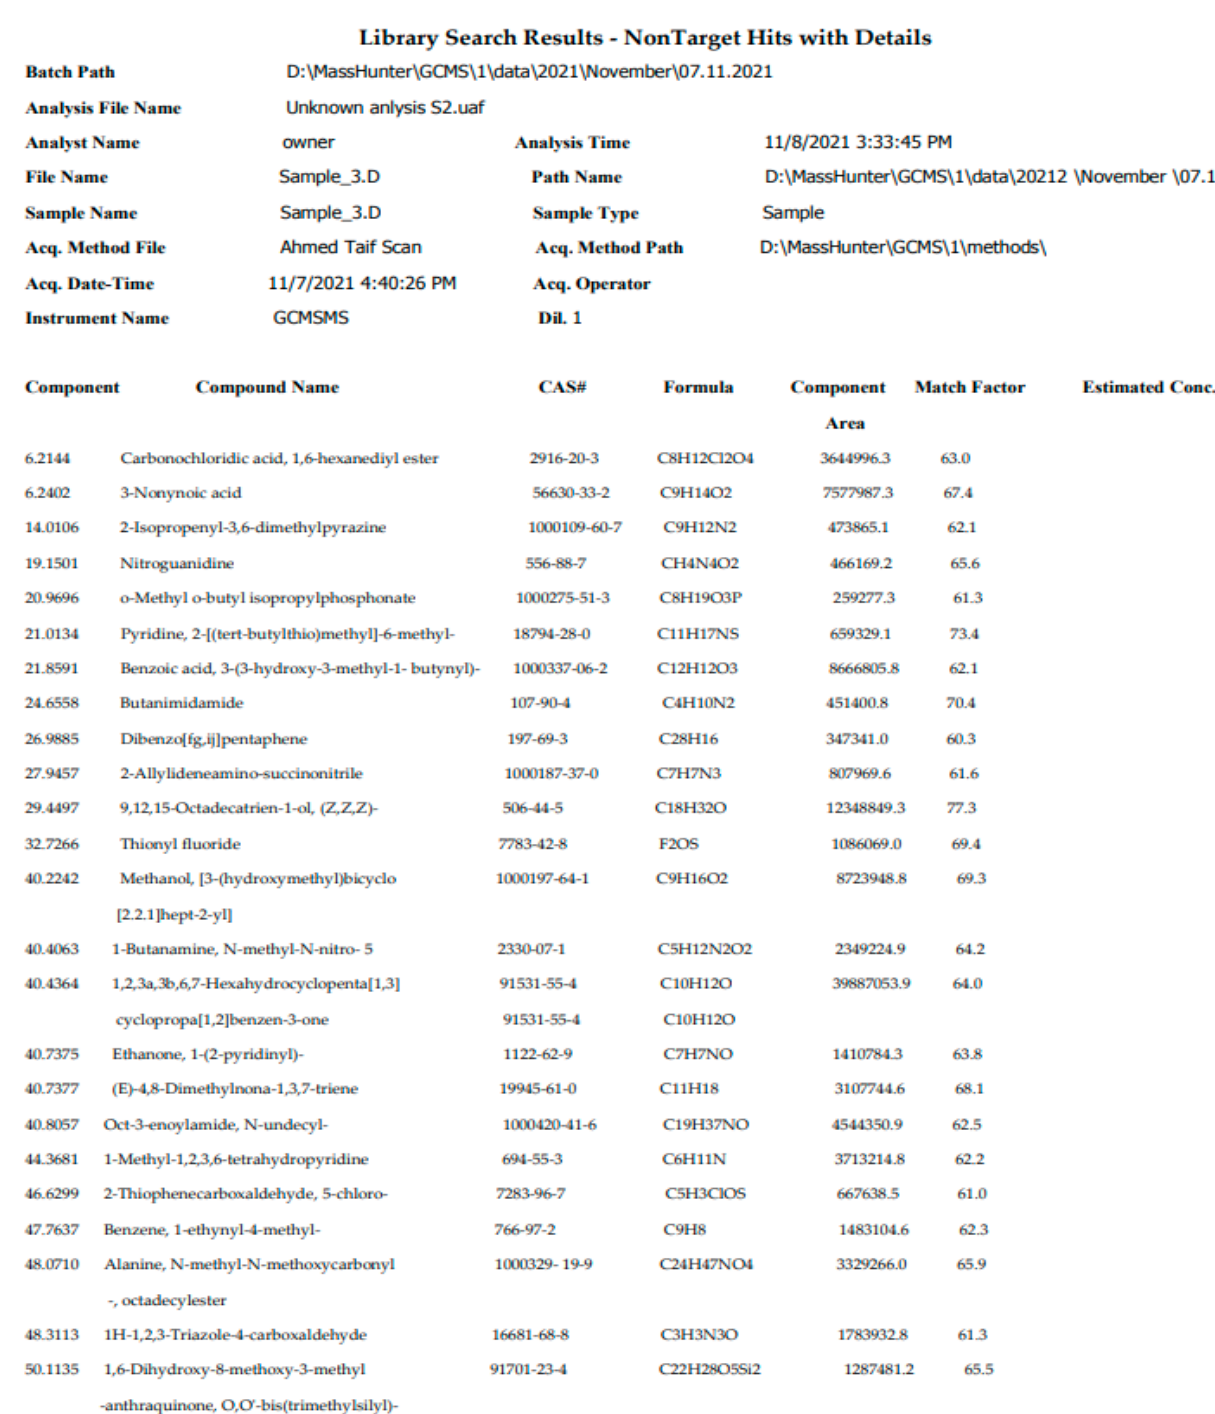
Figure 1. GC-MS analysis and chemical composition of grass plant wastes. These compounds contained hydroxyl groups and/or double bonds that belonged